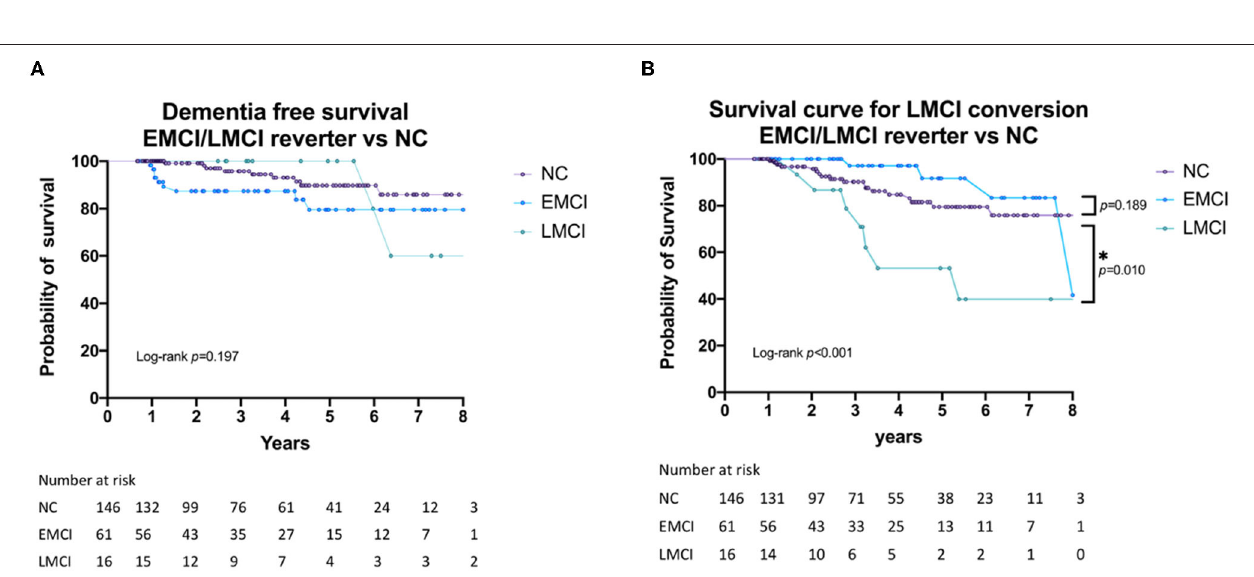
FIGURE 1 | Dementia-free survival for NC, EMCI, and LMCI participants. NC, normal cognition; EMCI, early mild cognitive impairment; LMCI, late mild cognitive impairment.